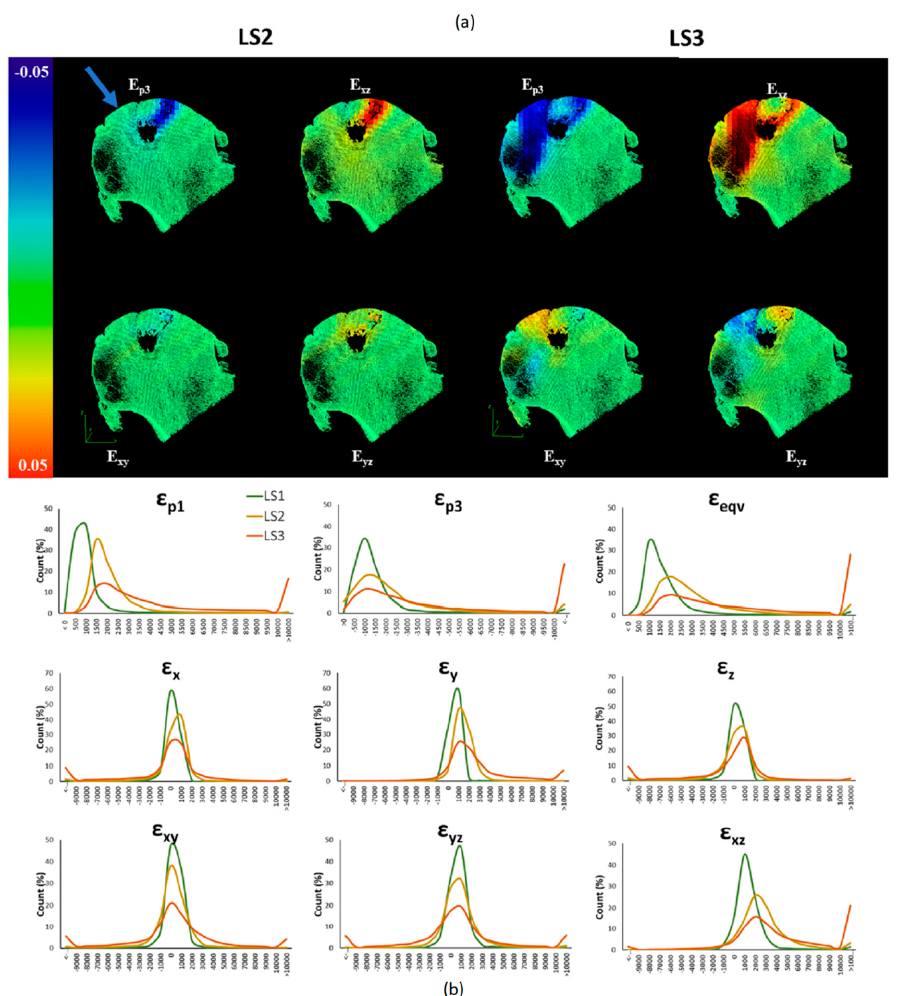
Figure 6. ( a ) 3D Renderings of 5 mm thick slices of Specimen 4 overlaid with the DVC output strain maps for ( ε p3, ε xy, ε yz and ε xz). The images highlight the localisation of strains around the large cyst at LS2 (LEFT), and LS3 (RIGHT). The load was applied on the superior side of the femoral head (blue arrow) perpendicular to the cut surface of the femoral neck. ( b ) Histograms illustrating frequency distribution for strain components ( ε p1 ε p3 ε eqv ε x ε y ε z ε xy ε yz ε xz) and incremental